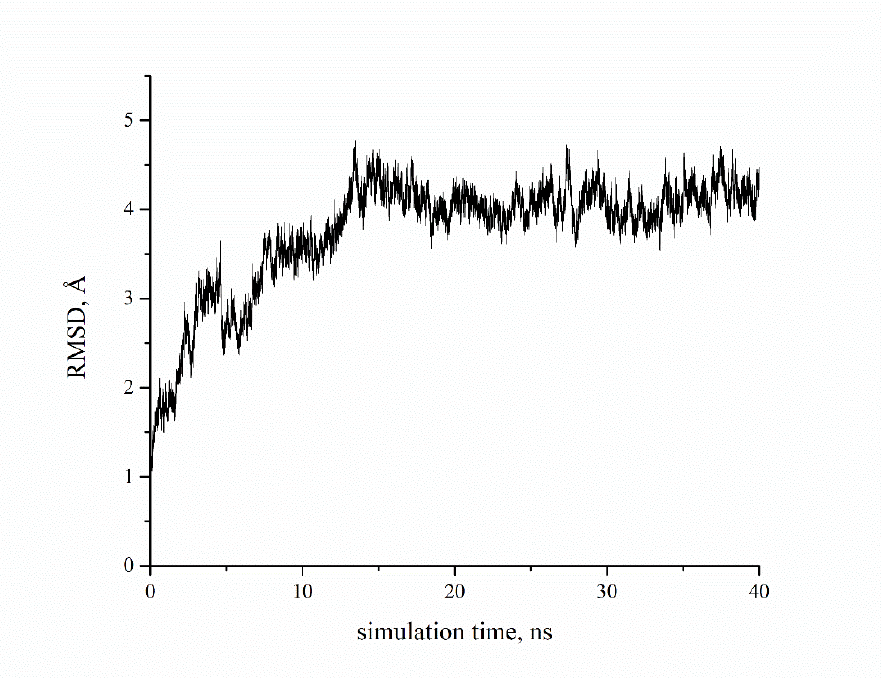
Figure 6. RMSD of 5HT6 backbone atoms during the production phase of complex with ZINC00756618.